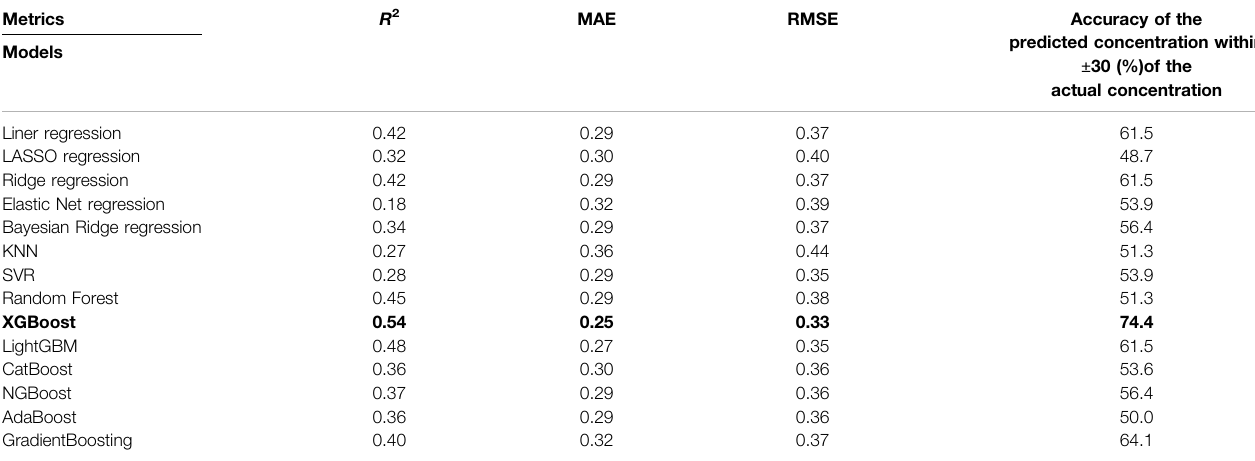
TABLE 2 | Performance of 14 models. Metrics R 2 MAE RMSE Accuracy of the concentrationModels Liner regression